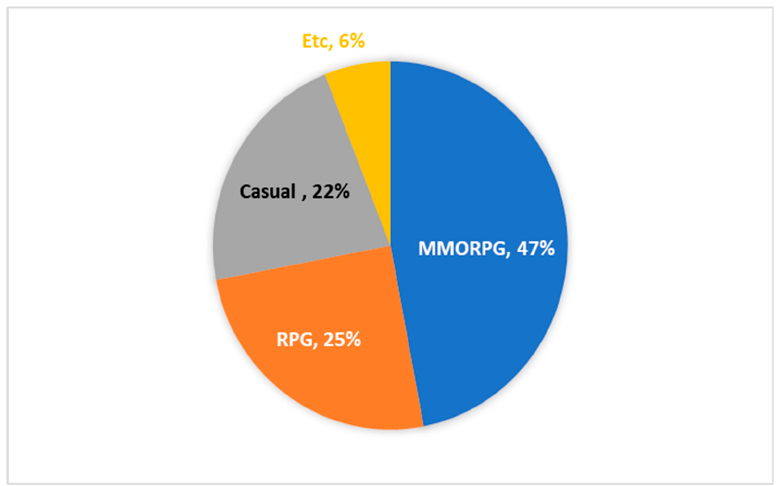
Figure 5. Sales Breakdown by Game Genres (%) [18]. Graph created by the authors. Source: [18]